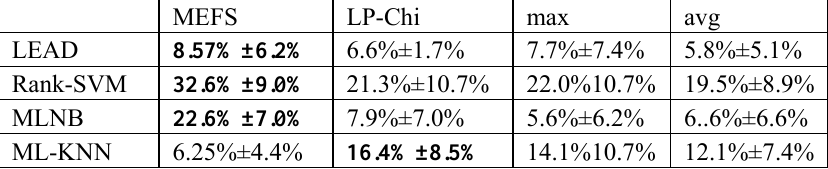
Table 7. Improvements obtained by employing each feature selection